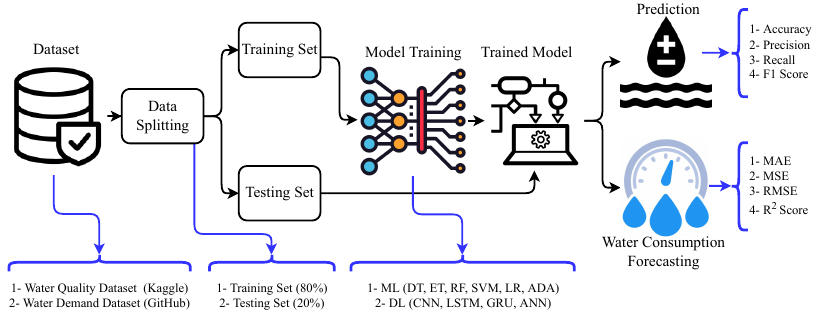
Figure 1. Architecture of the adopted methodology in this study.